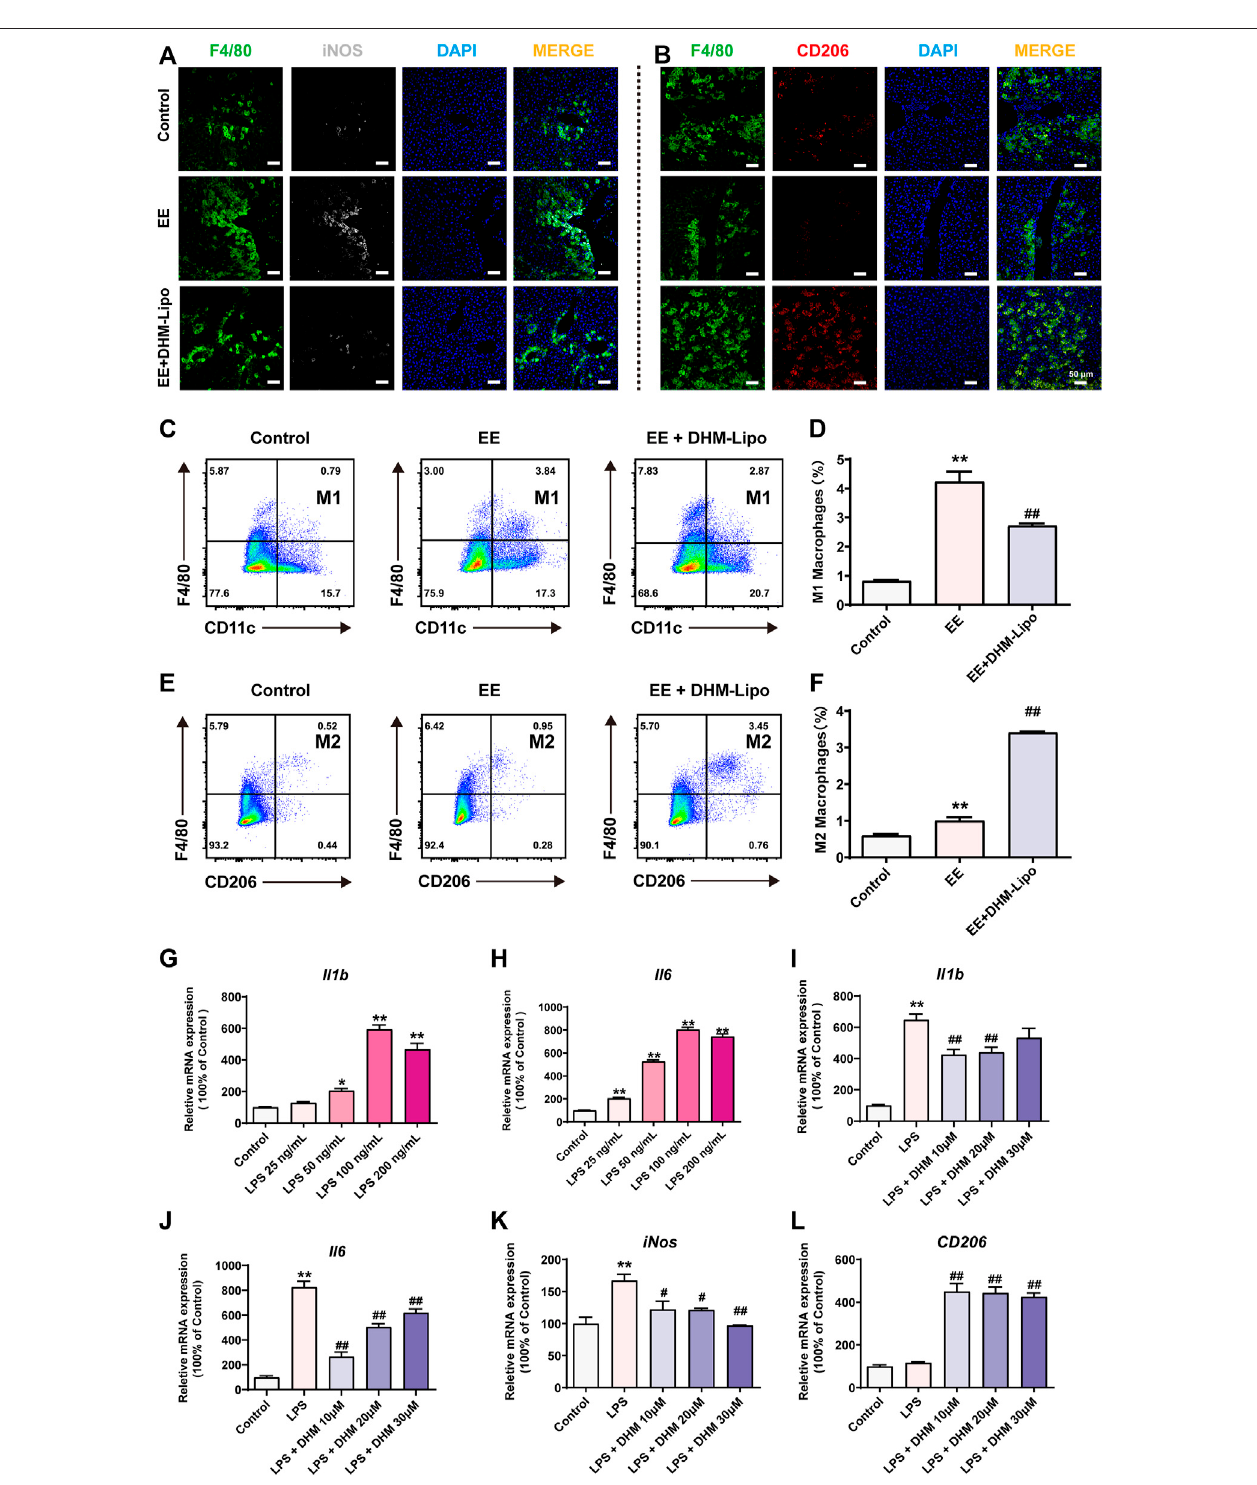
FIGURE 5 | DHM treatment promoted a shift in liver macrophage polarity (A) Representative immuno fl uorescence images of F4/80 (green, amacrophage marker) and iNOS (white, M1 type) (B) Representative immuno fl uorescence images of F4/80 (green) and CD206 (red, M2 type) (C – F) The frequency of M1-type macrophages (cells gated by CD45 + F4/80 + CD11c + ) and M2-type macrophages (cells gated by CD45 + F4/80 + CD206 + ) by FCM (G – H) RAW264.7 cells were treated with a series of concentrations (0, 25, 50, 100, and 200 ng/ml) of LPS, and the mRNA expression of Il1b and Il6 was detected by qRT – PCR (I-L) Preincubation with a series of concentrations (0, 10, 20, and 30 μ M) of DHM for 2 h before treatment with LPS (100 ng/ml) for 24 h. The mRNA expression levels of Il1b , Il6 , iNOS, and CD206 were detectedbyqRT – PCR.Dataarepresentedasthemean±SEM( n =3).* p < 0.05,** p < 0.01,comparedtothecontrolgroup; # p < 0.05, ## p < 0.01,comparedtotheLPS group. Scale bar = 50